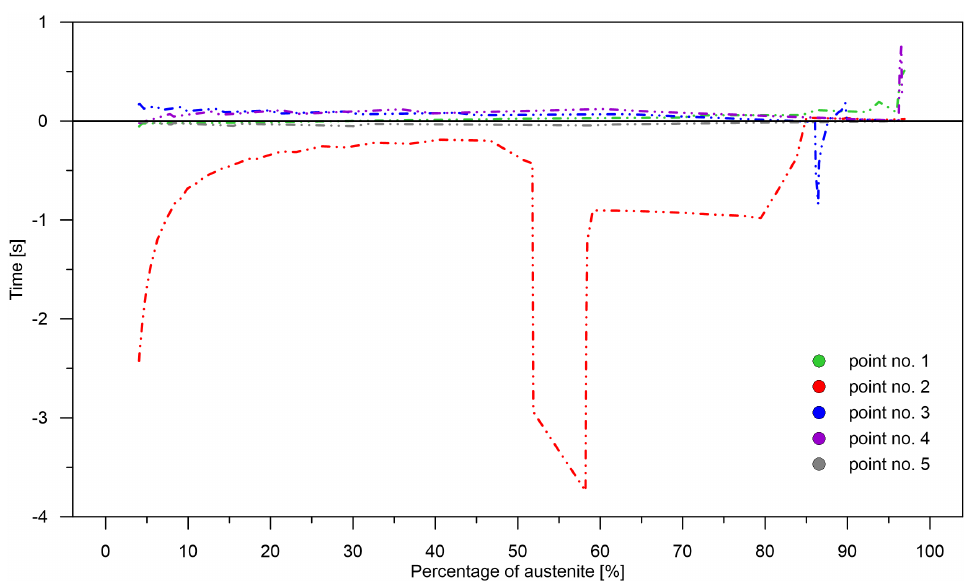
Figure 10. Analysis No. 1 and No. 2—rate of update of transformation